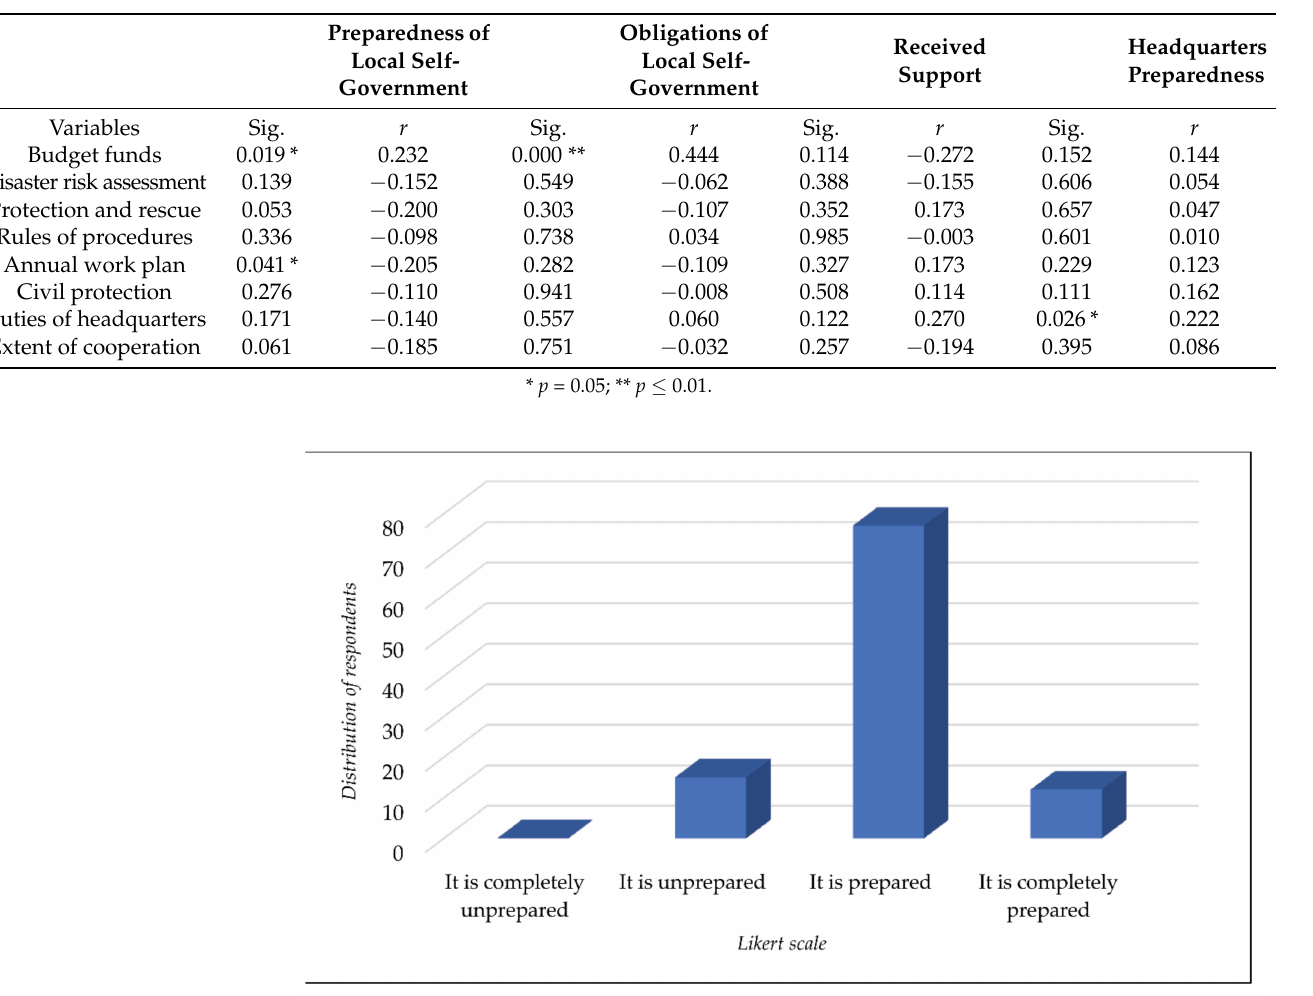
Table 3. Pearson’s correlation results for the relationship between the capacity development of local self-governments for DRM and predictor variables.